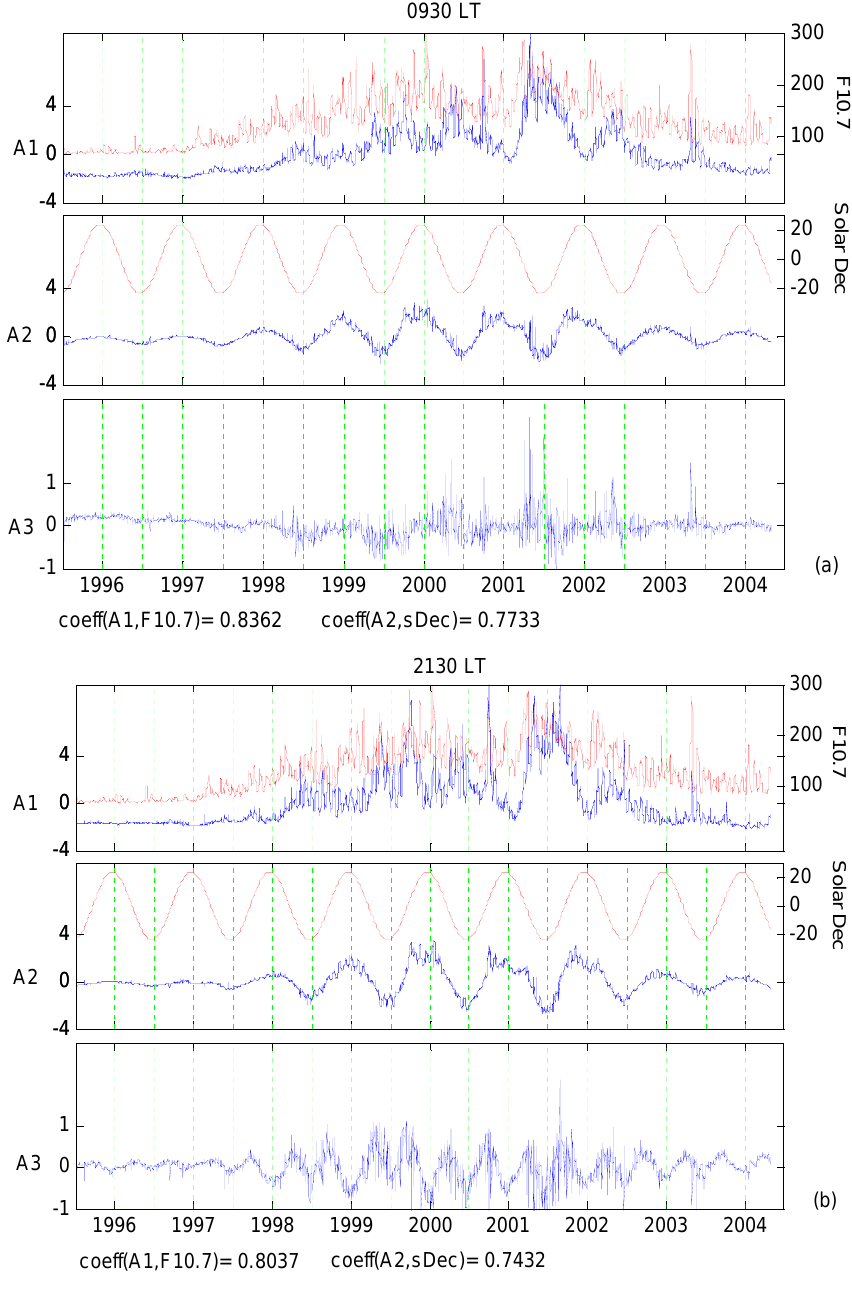
Fig. 4. Time variation in first three principal components marked by blue lines and axes on the left-hand side of the figures. Associated Figure 4 . Time variation in first three principal components marked by blue lines and geophysical parameters ( F 10 . 7 , and solar declination) are shown as red lines with values according to axes on the right-hand side of the axes on left-hand side of figures. Associated geophysical parameters (F 10.7 , and solar figures. The upper panel (a) represents those of 09:30 LT and (b) denotes those of 21:30 declination) are shown as red lines with values according to axes on right-hand side of figures. The upper panel (a) represents those of 0930 LT and (b) denotes those of 2130 LT.